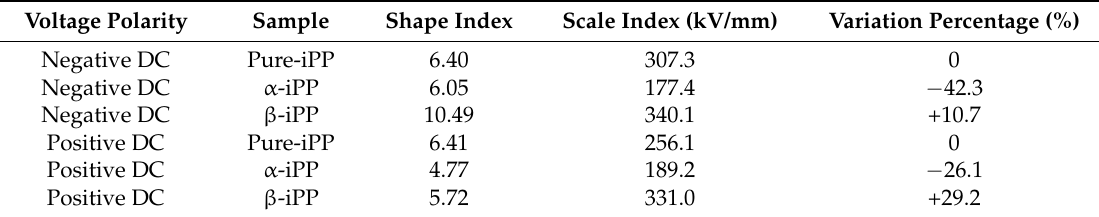
Table 2. Shape and scale indexes of iPP samples under different voltage